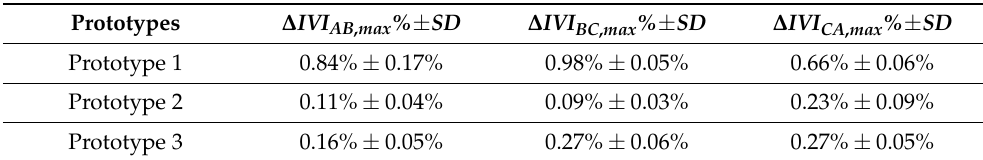
Figure 15. IVI measurements recorded for the three pairs of electrodes of Prototype 3 under altered leaflet dynamics: AB ( left ), BC ( center ) and CA ( right ). For each pair of electrodes of Prototypes 1, 2 and 3, the maximum percent variation of the impedance module ( 𝛥𝐼𝑉𝐼 (cid:3040)(cid:3028)(cid:3051) % ) was then calculated following Equation (1) (Table 2). Table 2. For each pair of electrodes (AB, BC and CA) of the three prototypes, maximum percent variation of the impedance module ( 𝛥𝐼𝑉I (cid:3040)(cid:3028)(cid:3051) % ), reported as 𝑀𝑒𝑎𝑛 𝑉𝑎𝑙𝑢𝑒 (cid:3399) 𝑆𝐷 , is shown for the “altered” working condition.